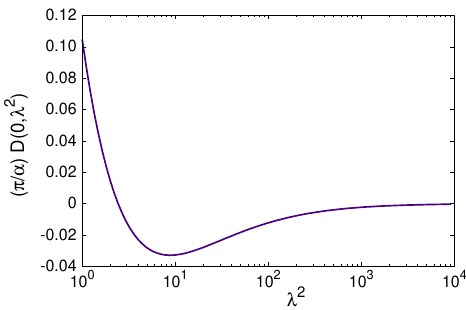
Figure 1: The λ 2 dependence of D ( t = 0, λ 2 ) . The minimum is at λ 2